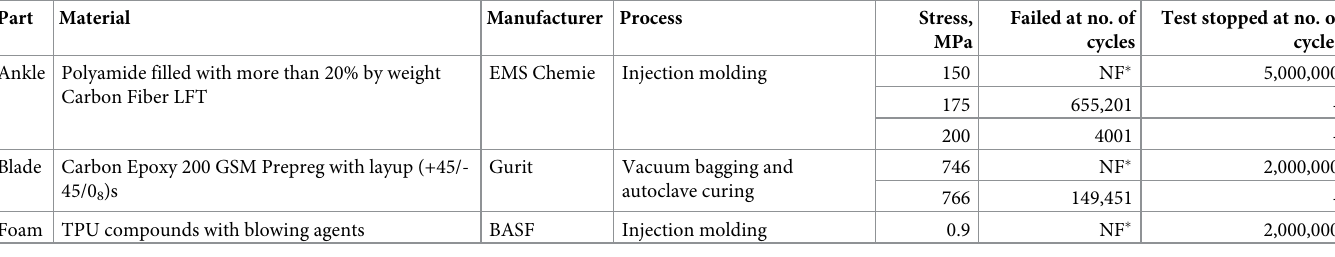
Table 3. Fatigue tests of the ankle and blade